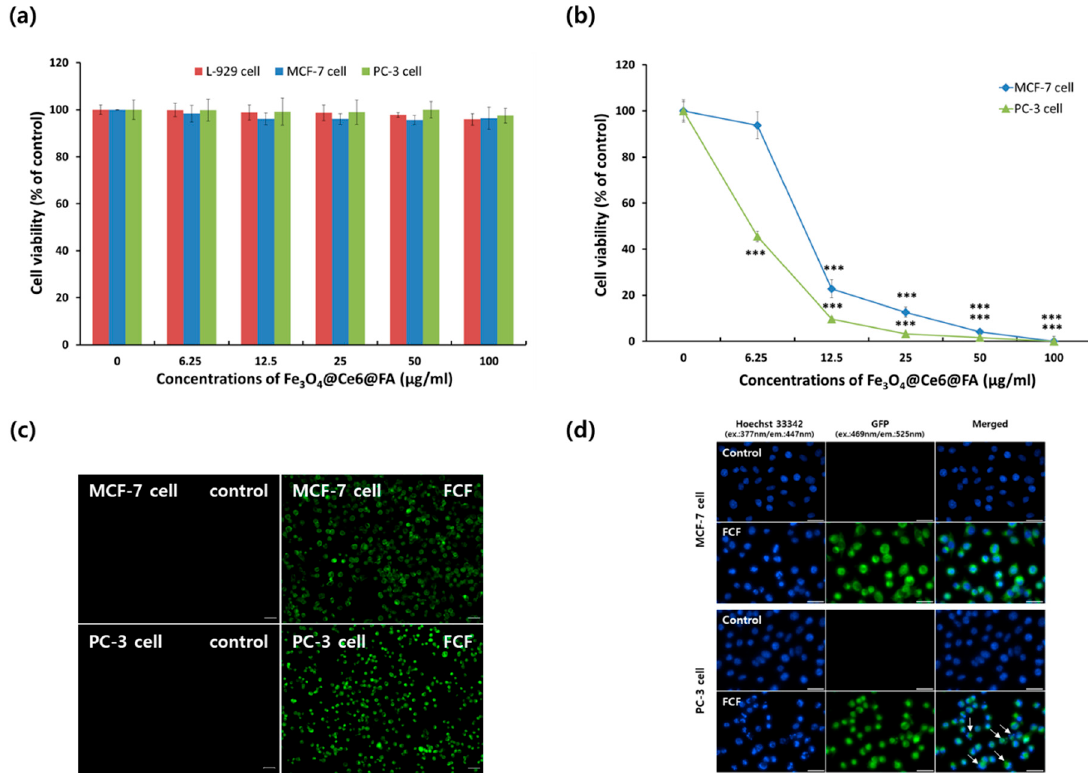
Figure 4. Biocompatibility and photodynamic anticancer activities of chlorin e6 and folic acid-conjugated magnetite (Fe 3 O 4 -Ce6-FA) nanoparticles. ( a ) Cytotoxicity and ( b ) phototoxicity of Fe 3 O 4 -Ce6-FA nanoparticles in MCF-7 (breast adenocarcinoma) and PC-3 (prostate adenocarcinoma) cell lines. Quantitative data are expressed as the mean ± standard deviation ( n = 4), and the statistical comparisons were evaluated using Student’s t -test. Significant differences were indicated by p < 0.05 (*** p < 0.0005 vs. control). ( c ) Images of MCF-7 and PC-3 cells after staining with fluorescein isothiocyanate-conjugated Annexin V (Annexin V-FITC) thus demonstrating the membrane translocation of the cells. The green fluorescence signal was produced by Annexin V-FITC. “FCF” represents Fe 3 O 4 -Ce6-FA nanoparticles. Scale bar = 50 μ m. ( d ) Nuclear fragmentation and caspase-3/7 activity in MCF-7 and PC-3 cells. The cells were stained with Hoechst 33342 to detect nuclear fragmentation and CellEvent Caspase-3/7 Green Detection reagent to detect caspase-3/7 activity after 6 h post photodynamic therapy at 20 mW for 30 min. Arrows represent apoptotic bodies of cells. Scale bar= 30 μ m.